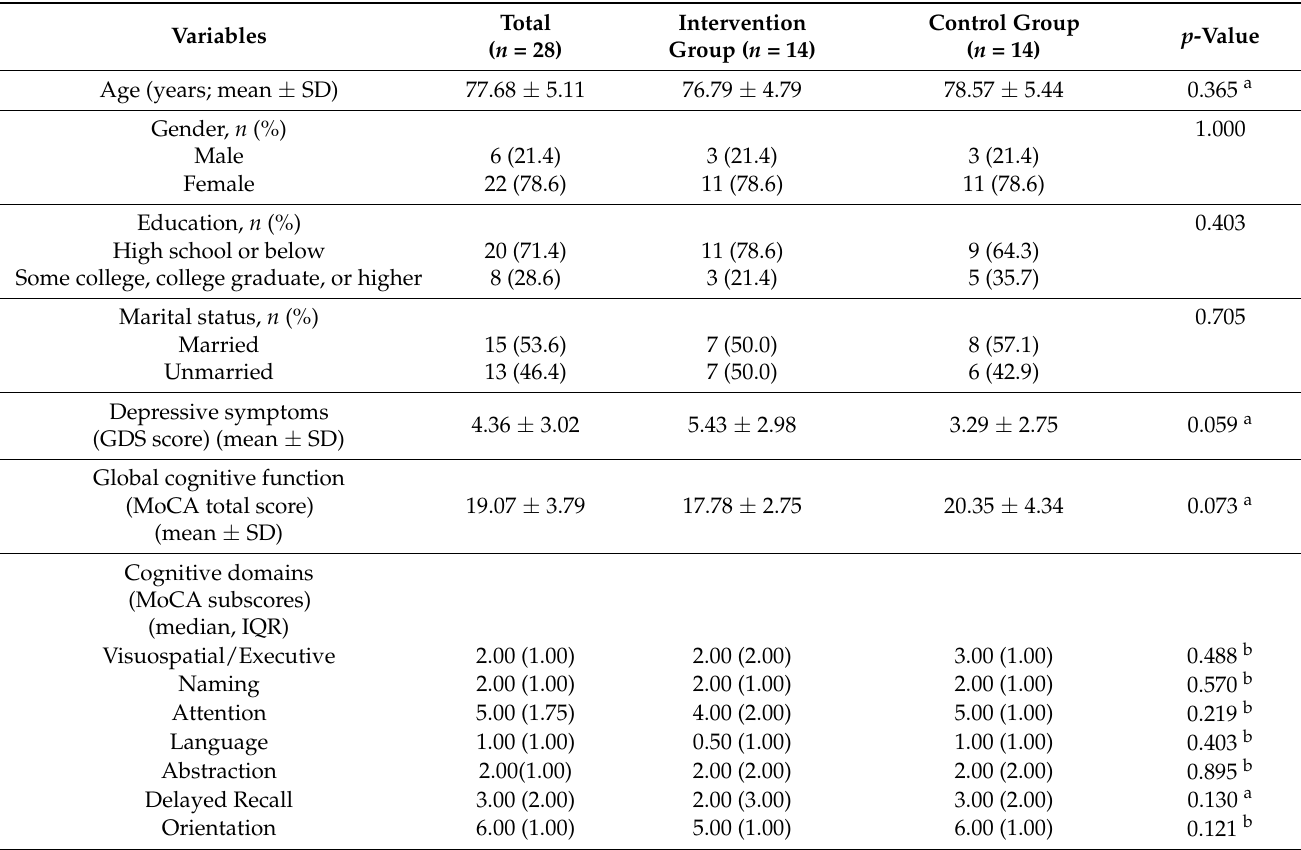
Table 1. Characteristics of the sample at baseline.